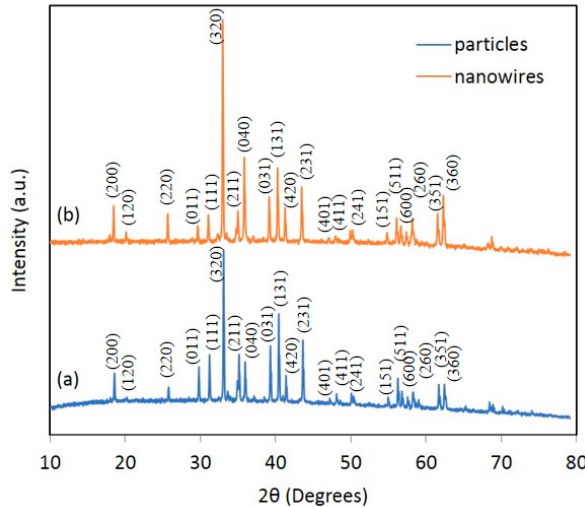
Figure 1. X-ray di ff raction instrument (XRD) patterns of ( a ) irregular-shaped CaMn 2 O 4 particles, and ( b ) CaMn 2 O 4 nanowires.